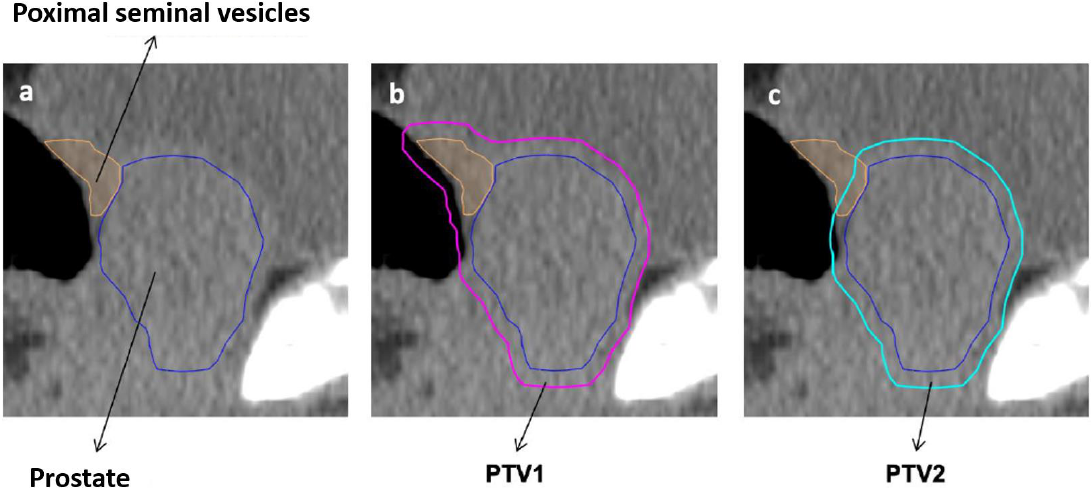
Figure 1. Definition of PTV1 and PTV2 for SBRT. Clinical target volume 1 (CTV1) and CTV including seminal vesicles (CTV_SV) are merged and expanded isotropic with a 4mm margin to create planning target volume 1 (PTV1) ( a , b ). PTV 2 is created by 4 mm isotropic expansion of CTV 1 ( c ).